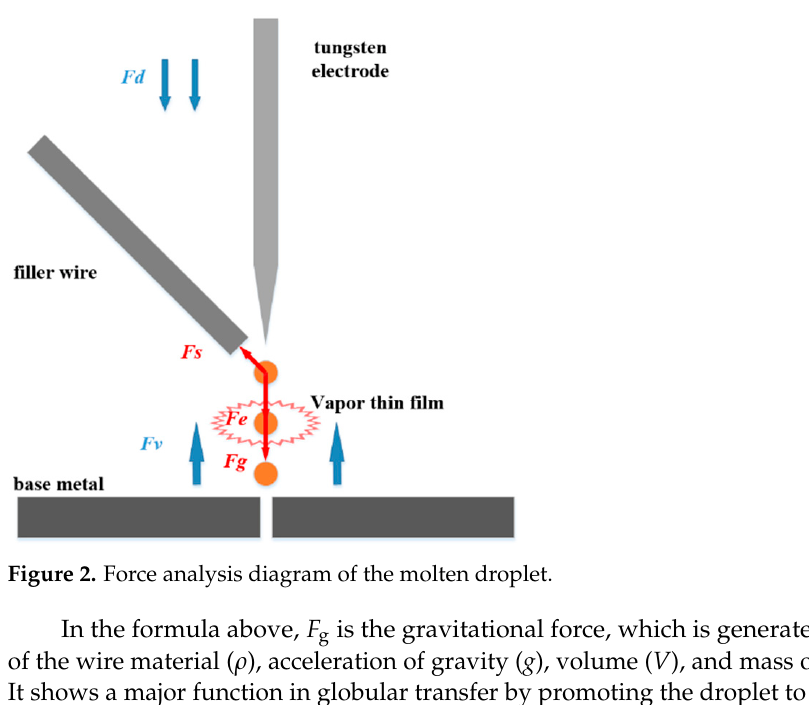
pool. It is given